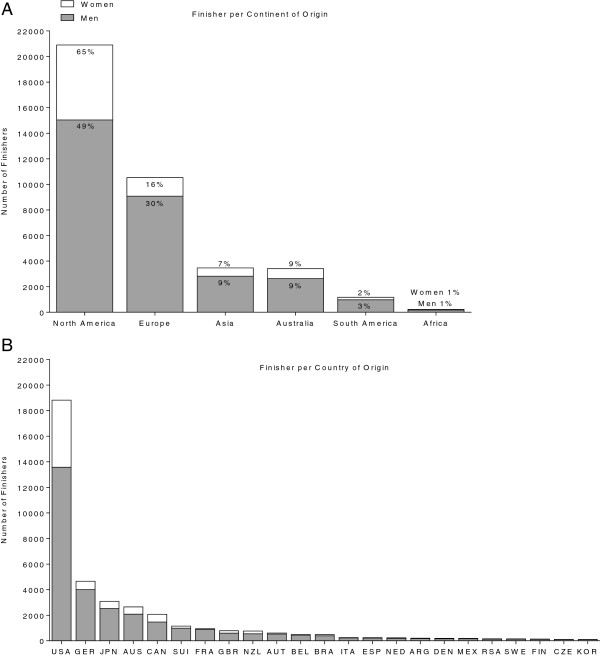
Number of female and male finishers per continent of origin in ‘Ironman Hawaii’ (Panel A) and number of female and male finishers per country of origin (Panel B). USA = United States of America, GER = Germany, JPN = Japan, AUS = Australia, CAN = Canada, SUI = Switzerland, FRA = France, GBR = Great Britain, NZL = New Zealand, AUT = Austria, BEL = Belgium, BRA = Brazil, ITA = Italy, ESP = Spain, NED = Netherlands, ARG = Argentina, DEN = Denmark, MEX = Mexico, RSA = Republic South Africa, SWE = Sweden, Fin = Finland, CZE = Czech Republic, KOR = Korea.